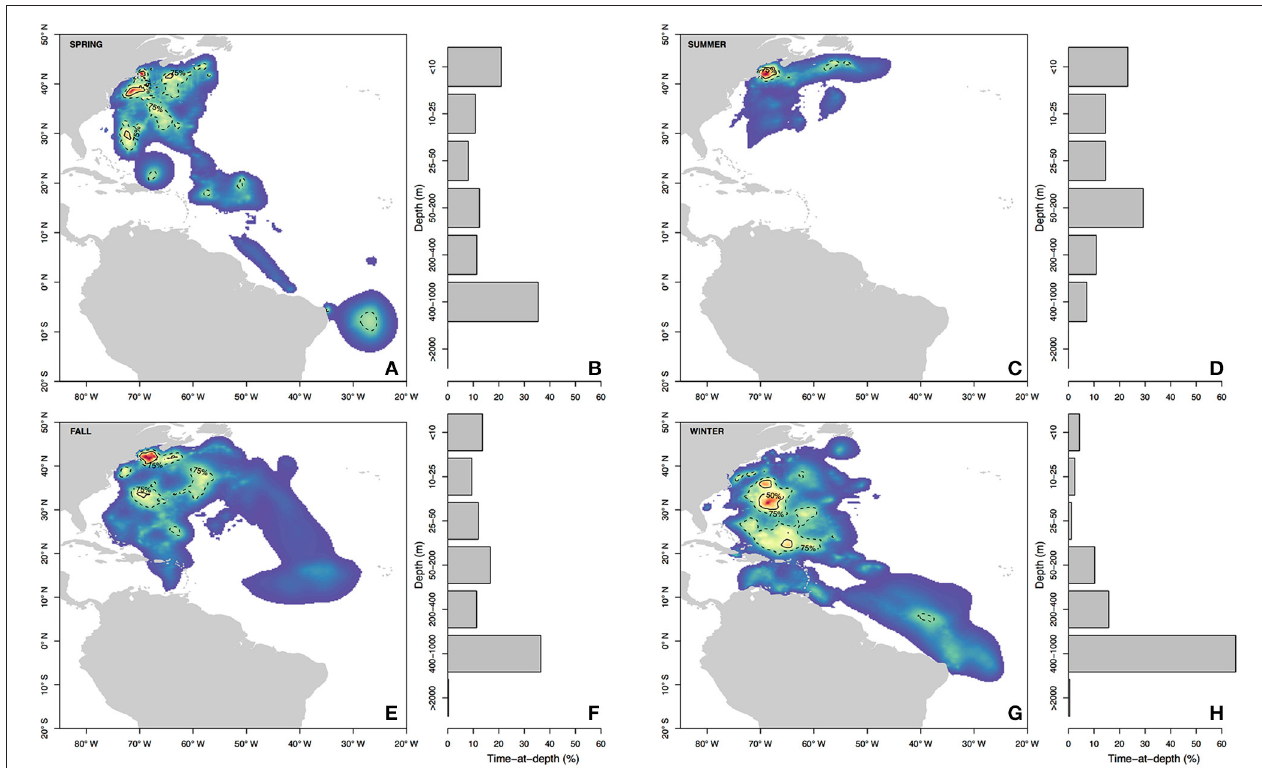
FIGURE 3 | Seasonal residency distributions (A,C,E,G) and cumulative time-at-depth (B,D,F,H) for spring (A,B) , summer (C,D) , fall (E,F) , and winter (G,H) . Residency distributions were calculated using the HMMoce package for R. Contour lines represent 50 and 75% of occupation for a given season as depicted by solid and dashed contours, respectively.